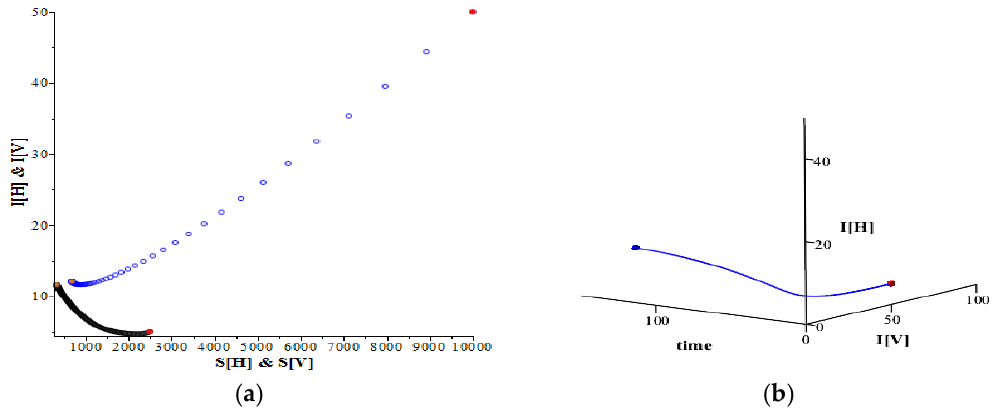
Figure 4. The phase port of S H ( t ) and I H ( t ) (black) and the phase port of S V ( t ) I V ( t ) (blue) are shown in ( a ). ( b ) shows the trajectory of I H ( t ) and I V ( t ) in a 3D graph. The red dots in both figures indicate the initial values of the system. The parameters are the same as in Figure 3.